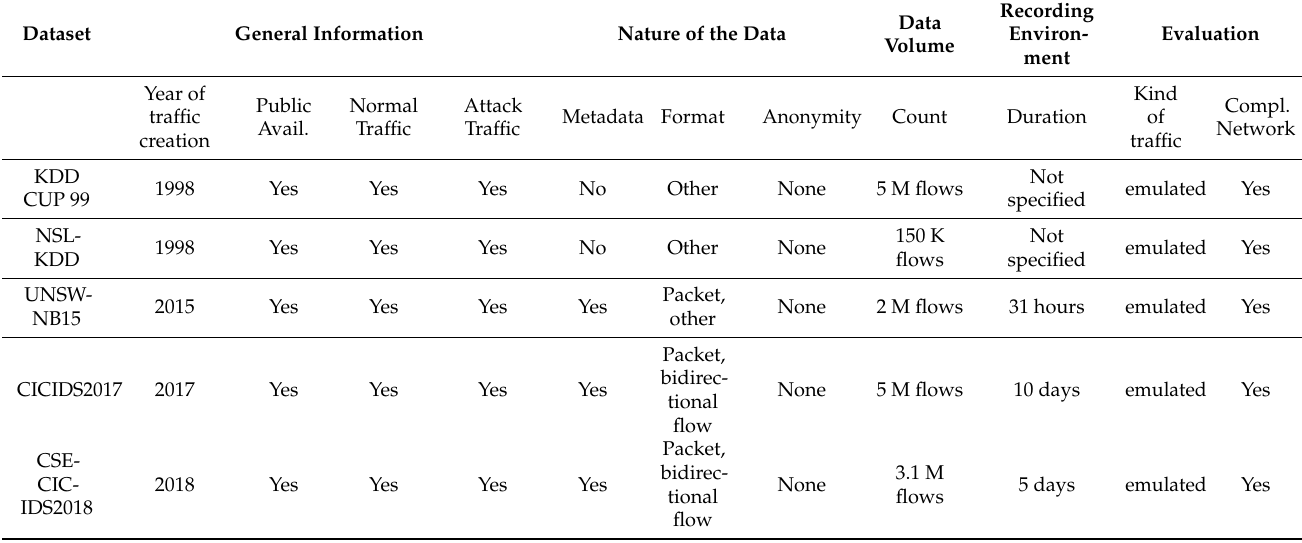
Table A1. Network Intrusion Detection System